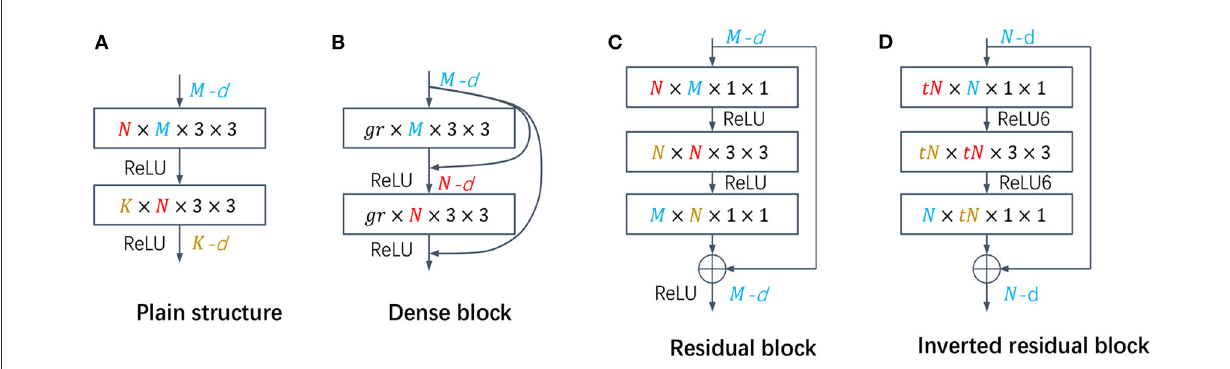
FIGURE3 (A) The plain structure in VGG, and the number of output channel pruning in each layer is directly calculated by the algorithm. (B) The dense block, the number of output channels of each layer is fixed ( gr ), and the number of input channels is calculated by the algorithm. (C, D) Residual block and inverted residual block, respectively. The pruning rate of all layers in the block is the same, and the number of input channels and output channels of each block is guaranteed to be the